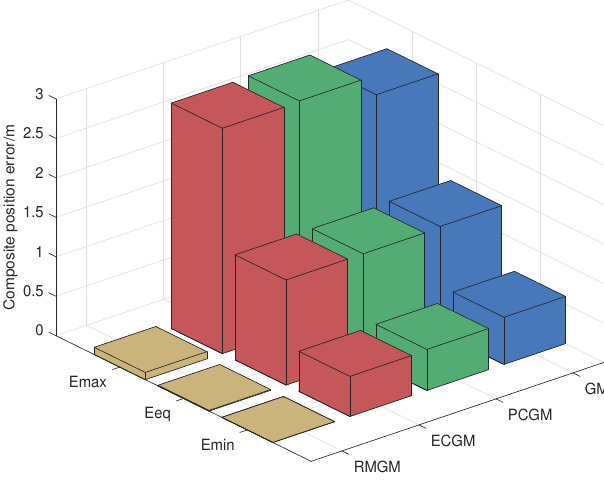
Figure 15. Composite position error calculated by the GM, ECGM, PCGM, and RMGM models in the